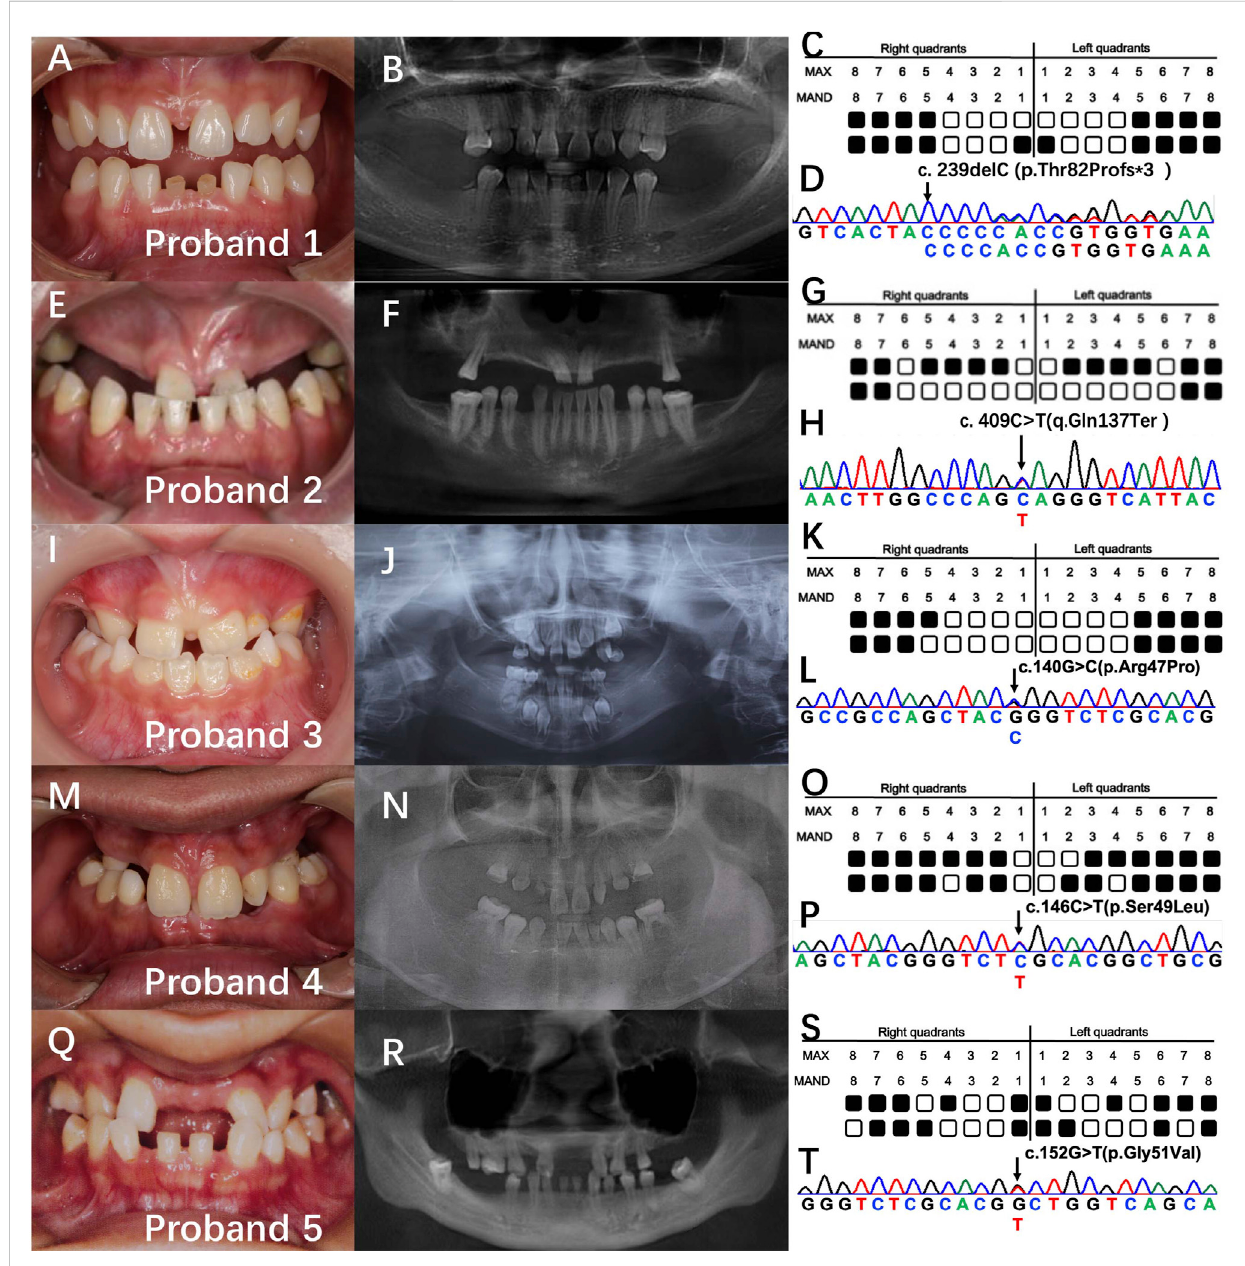
FIGURE 1 Clinical fi ndingsand geneticanalysisof fi veprobands. (A, E,I,M,Q) intraoral photos. (B, F,J, N,R) panoramicradiographs. (C, G,K, O,S) schematics of the tooth missing pattern of the proband. Black squares indicate missing tooth positions. (D, H, L, P, T) sequencing chromatograms of the proband.